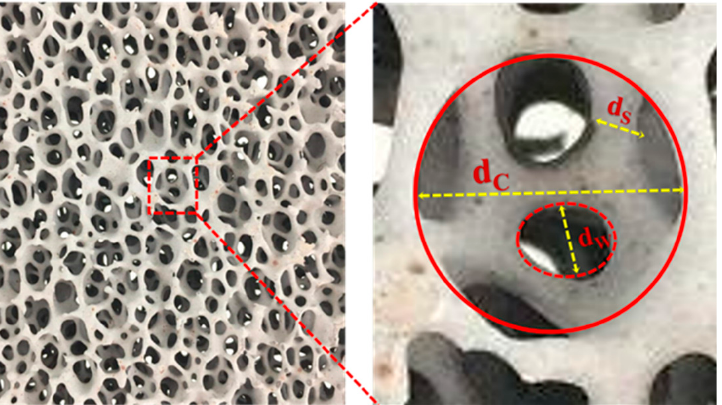
Figure 1. An uncut surface of a CFF of Grade 30, and the characteristic length scales, i.e., Cell ( d c ), Window ( d w ), and Strut ( d s ), which are indicated by the large solid circle, dotted circle, and double line arrow, respectively, in the enlarged section of image.